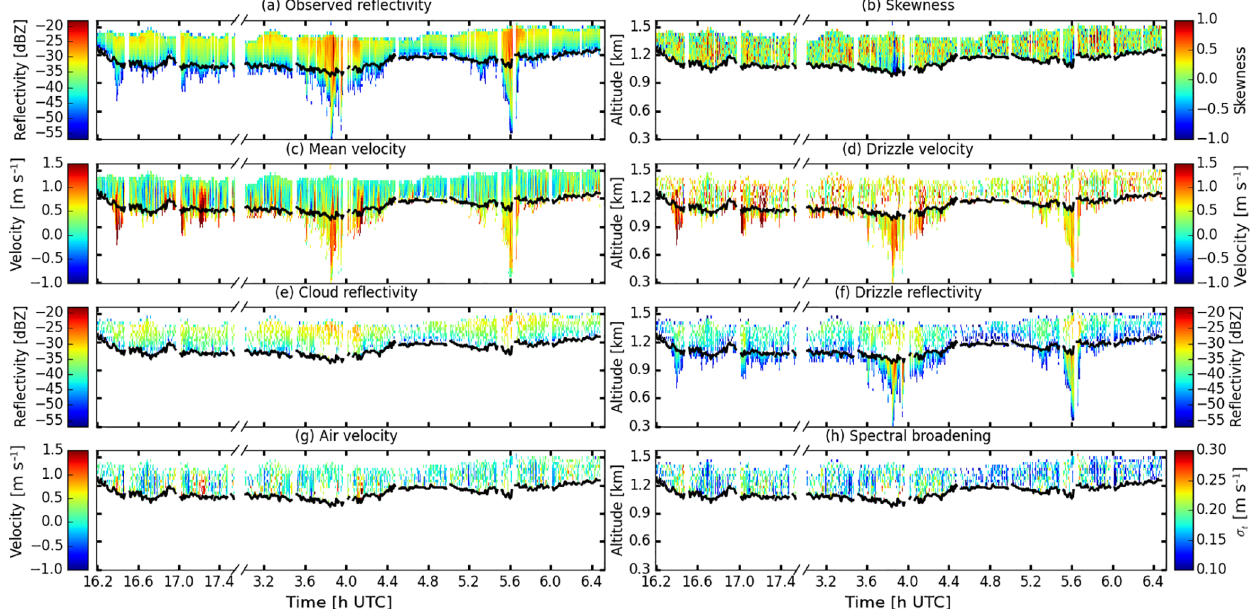
Figure A1. Results of the retrieval using Doppler spectra on 25 and 26 October 2014: (a) zeroth moment of the Doppler composite spectra; (b) skewness of the composite spectra above the cloud base; (c) – (d) first moments of the composite spectra and the drizzle spectra; (e) – (f) zeroth moments of the cloud and the drizzle spectra, respectively, as obtained from the spectral decomposition; (g) air velocity; and (h) spectral broadening due to turbulence. The breaks along the time axis mark the change of day. The black line delineates the cloud